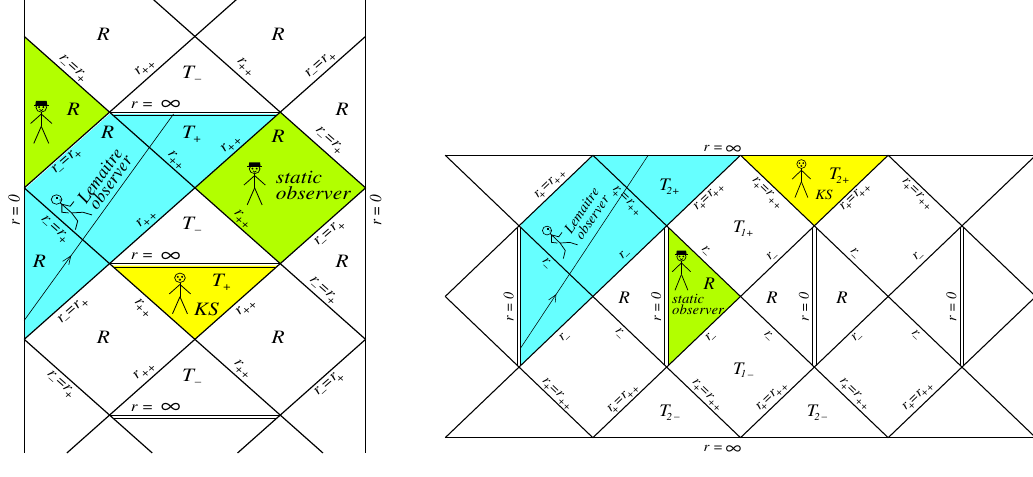
Figure 4. Left: Fragment of the global structure for M = M cr 1 , the double horizon r − = r + . Right: Fragment of the global structure for M = M cr 2 , the double-horizon r + = r ++